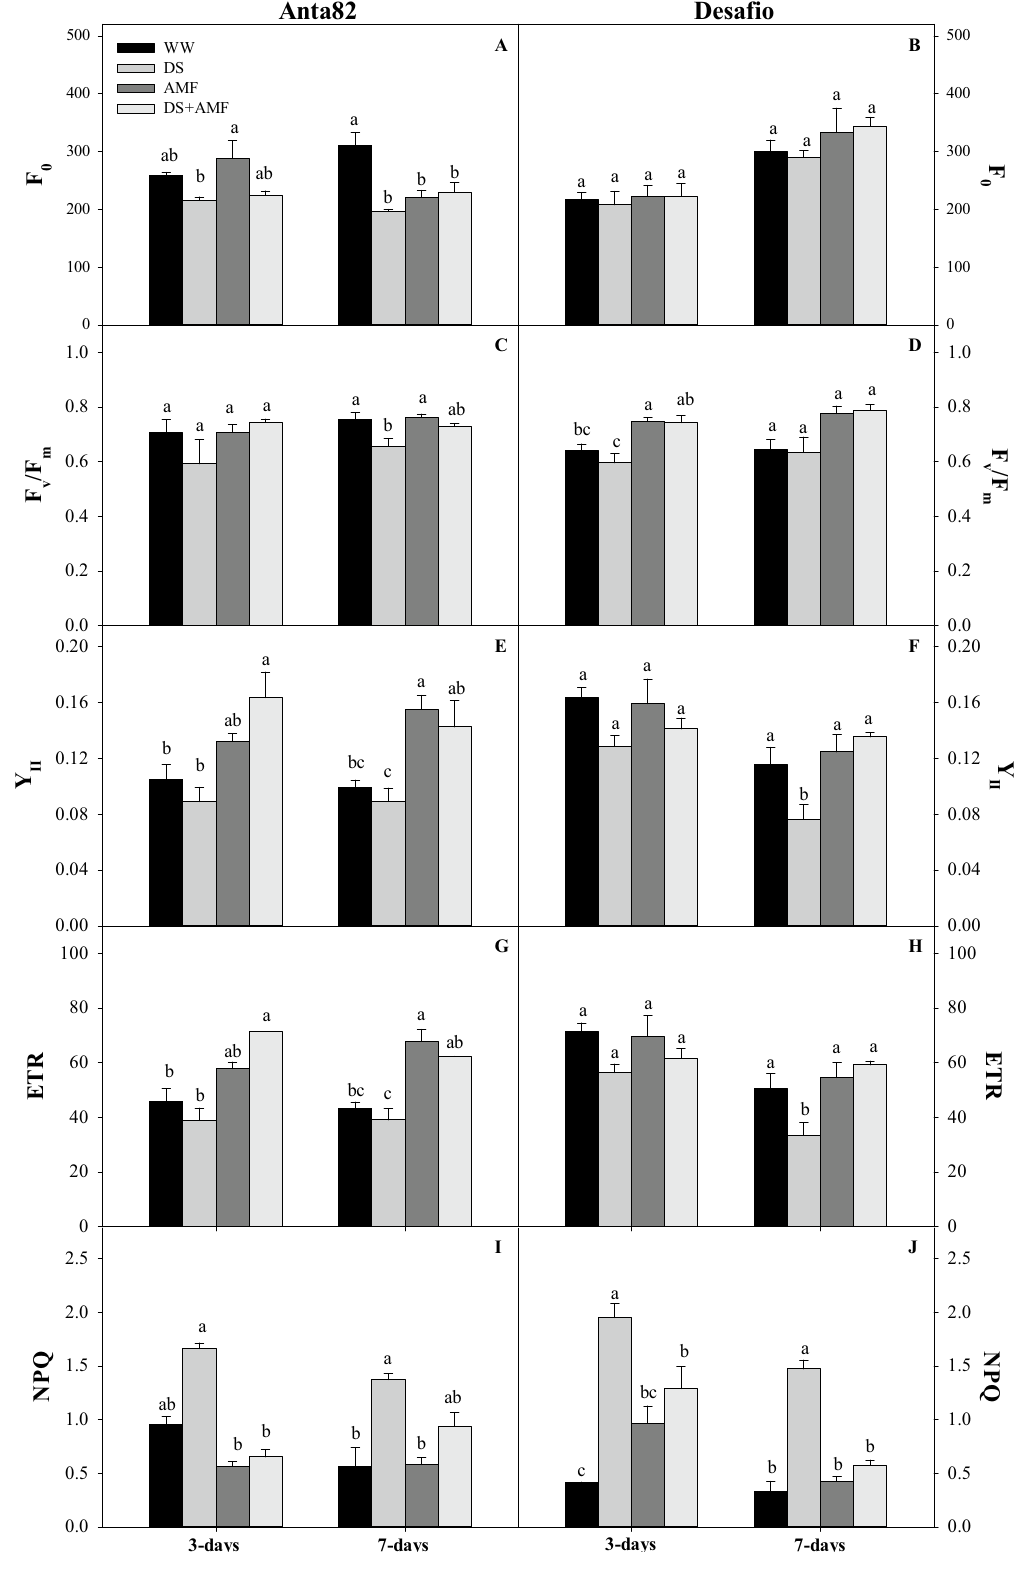
Figure 5. Minimal fluorescence (F 0 ), maximum quantum yield of the PSII (F v /F m ), effective quantum yield of PSII (Y II ), electron transport rate (ETR), and non-photochemical quenching (NPQ) on days 3 and 7 in the ( A , C , E , G , I ) Anta82 and ( B , D , F , H , J ) Desafio soybean cultivars under different conditions of inoculation and water stress. WW = well-watered, noninoculated, DS = drought stress, noninoculated, WW + AMF = well-watered and inoculated, DS + AMF = drought stress and inoculated. The bars represent the mean ± SEM ( n = 4). Pairs of means in the same period (3 or 7 days) with different letters are significantly different ( p < 0.05) based on Tukey’s post hoc